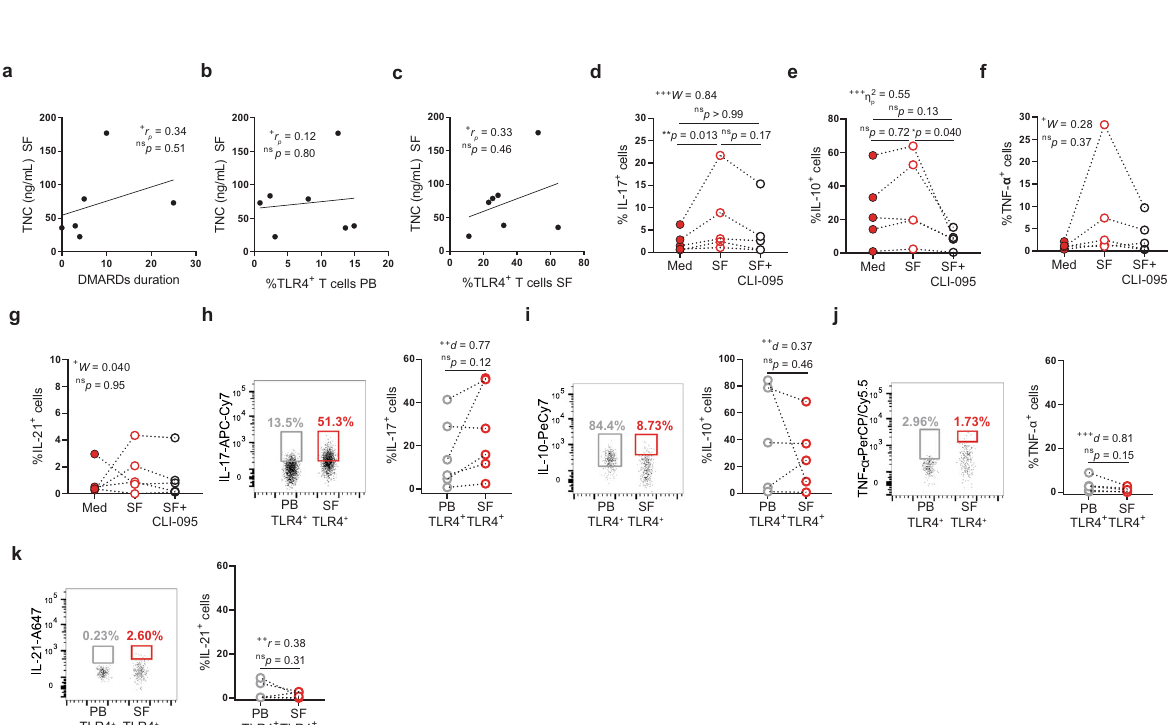
Fig. 10 Direct recognition of TLR4 ligands present in synovial fl uid drives IL-17 production, independently of antigen recognition. a – c Correlation between synovial fl uid tenascin-C levels and a DMARD duration ( n = 6 RA patients), b frequency of circulating (PB) TLR4 + T cells ( n = 7 RA patients), and c frequency of synovial fl uid (SF) TLR4 + T cells ( n = 7 RA patients). d – g FACS-puri fi ed CD3 high CD4 high T cells from peripheral blood were cultured for 18 hours in the presence of medium (Med), synovial fl uid (SF), or TLR4 signaling inhibitor (CLI-095). Frequency of d IL-17, e IL-10, f TNF- α , and g